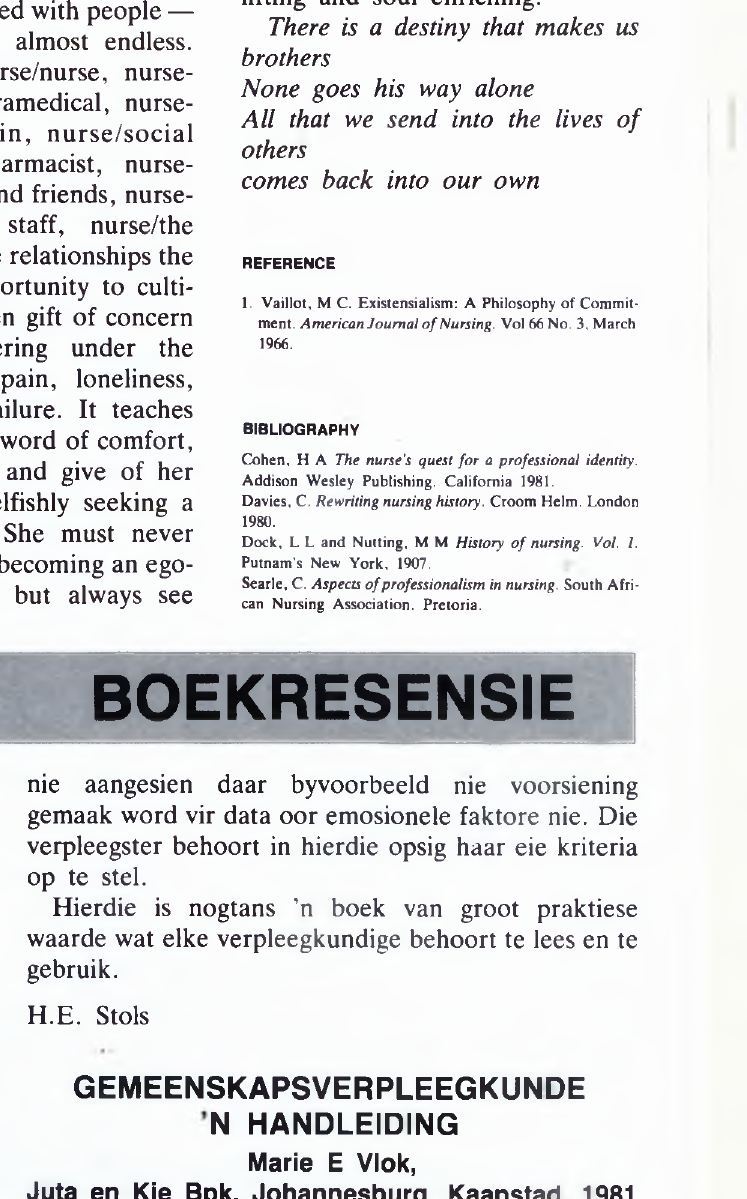
Die verpleegproses word prakties toegepas in 'n wye